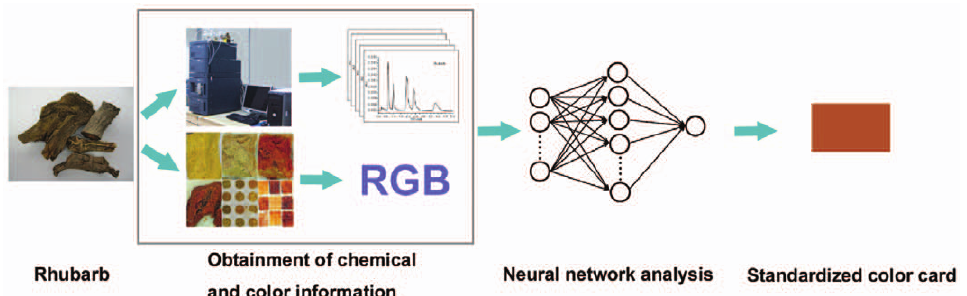
Figure 2. The flowchart for this study.